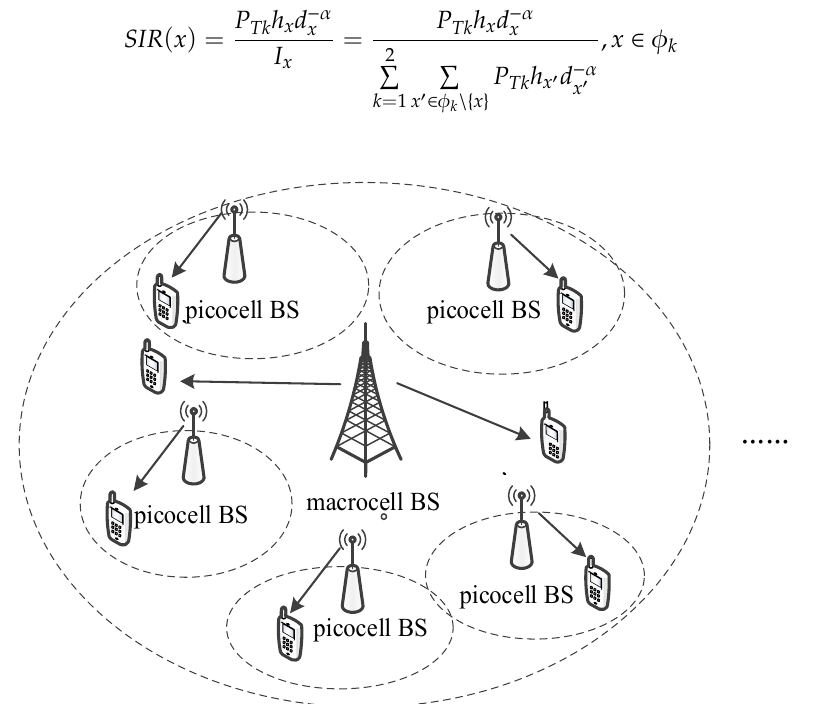
Figure 1. A two-tier, heterogeneous cellular network.